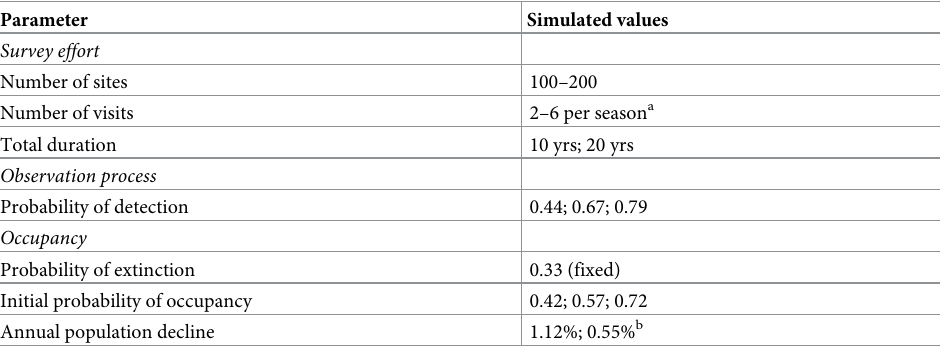
Table 1. Parameters and simulated values used in simulations of territory-occupancy monitoring of ferruginous